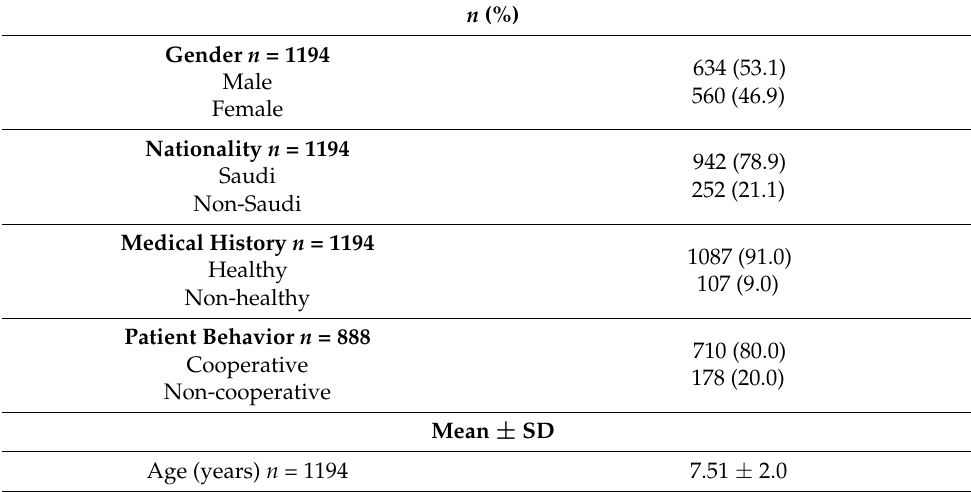
Table 2. Pearson correlations between adjacent decayed, sound, and filled 1st and 2nd primary mo- lars in the study sample ( n = 1194).